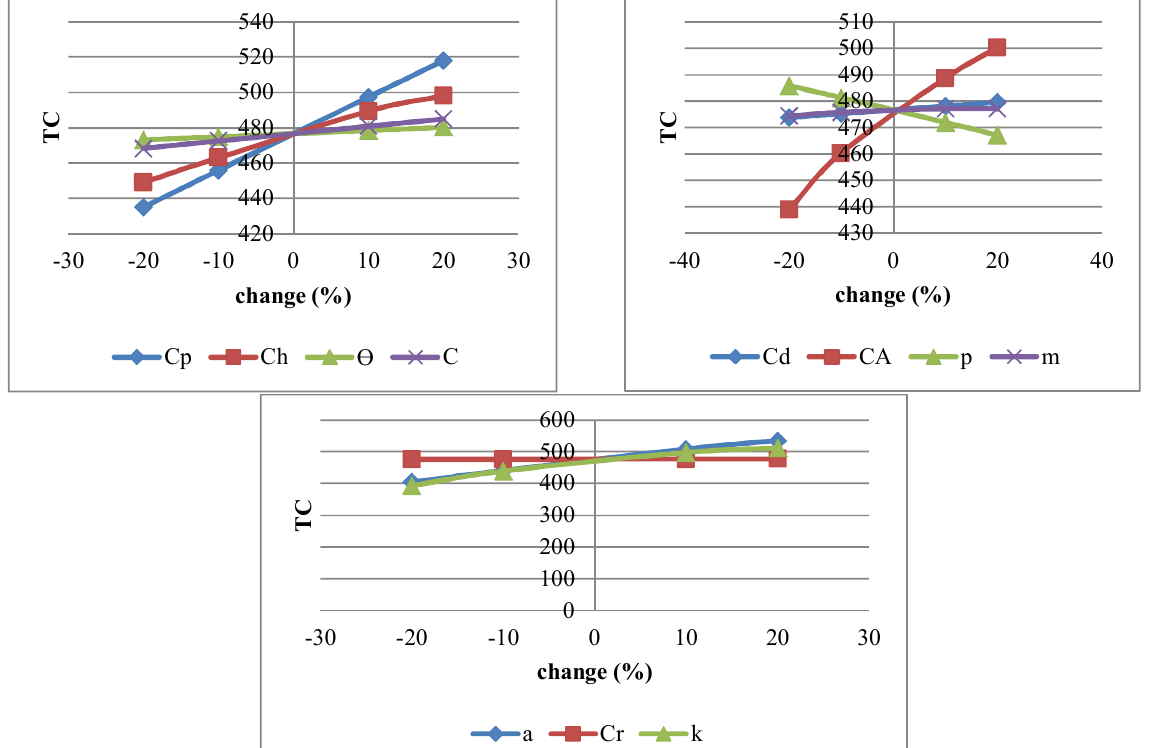
Fig. 11. (For example (2)) The effect of changing parameters on the optimal cost